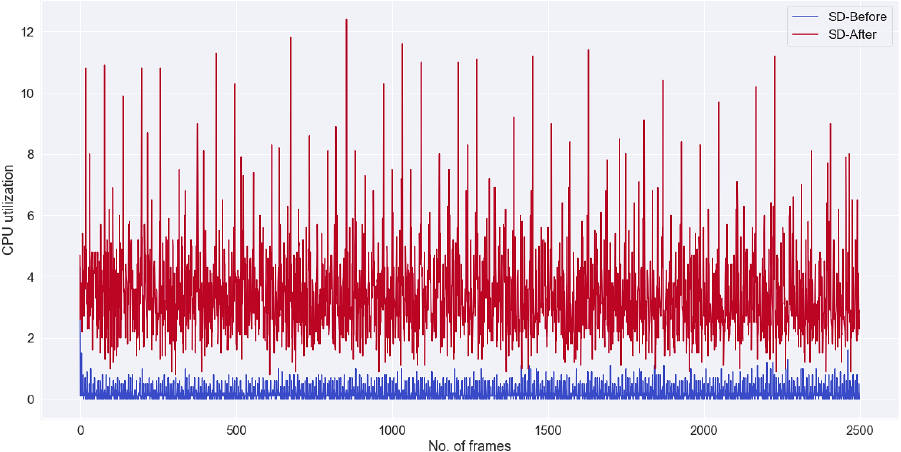
Figure 10. CPU utilization in standalone machine before and after OpenStack